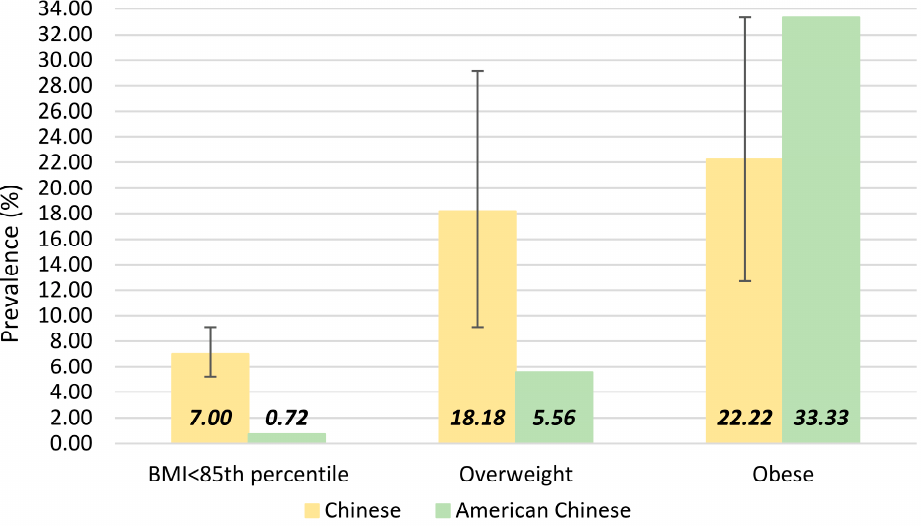
Figure 2. Prevalence of childhood suspected NAFLD according to different BMI categories and the comparison with the results in American Chinese children (data from [19]).